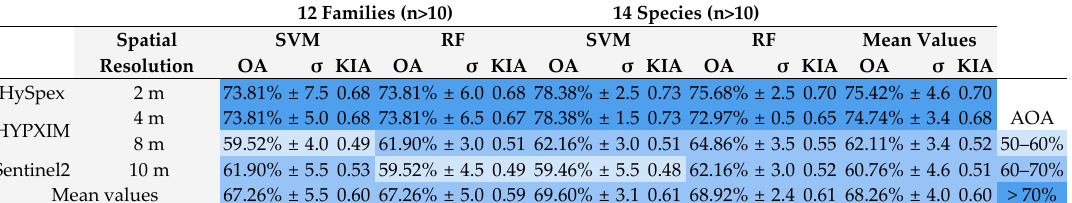
Table 6. Urban tree diversity classification results obtained using the 2-folds learning method and applied on reduced MNF image datasets, with SVM and RF classifiers according to subsets exhibiting at least 10 individuals per class.